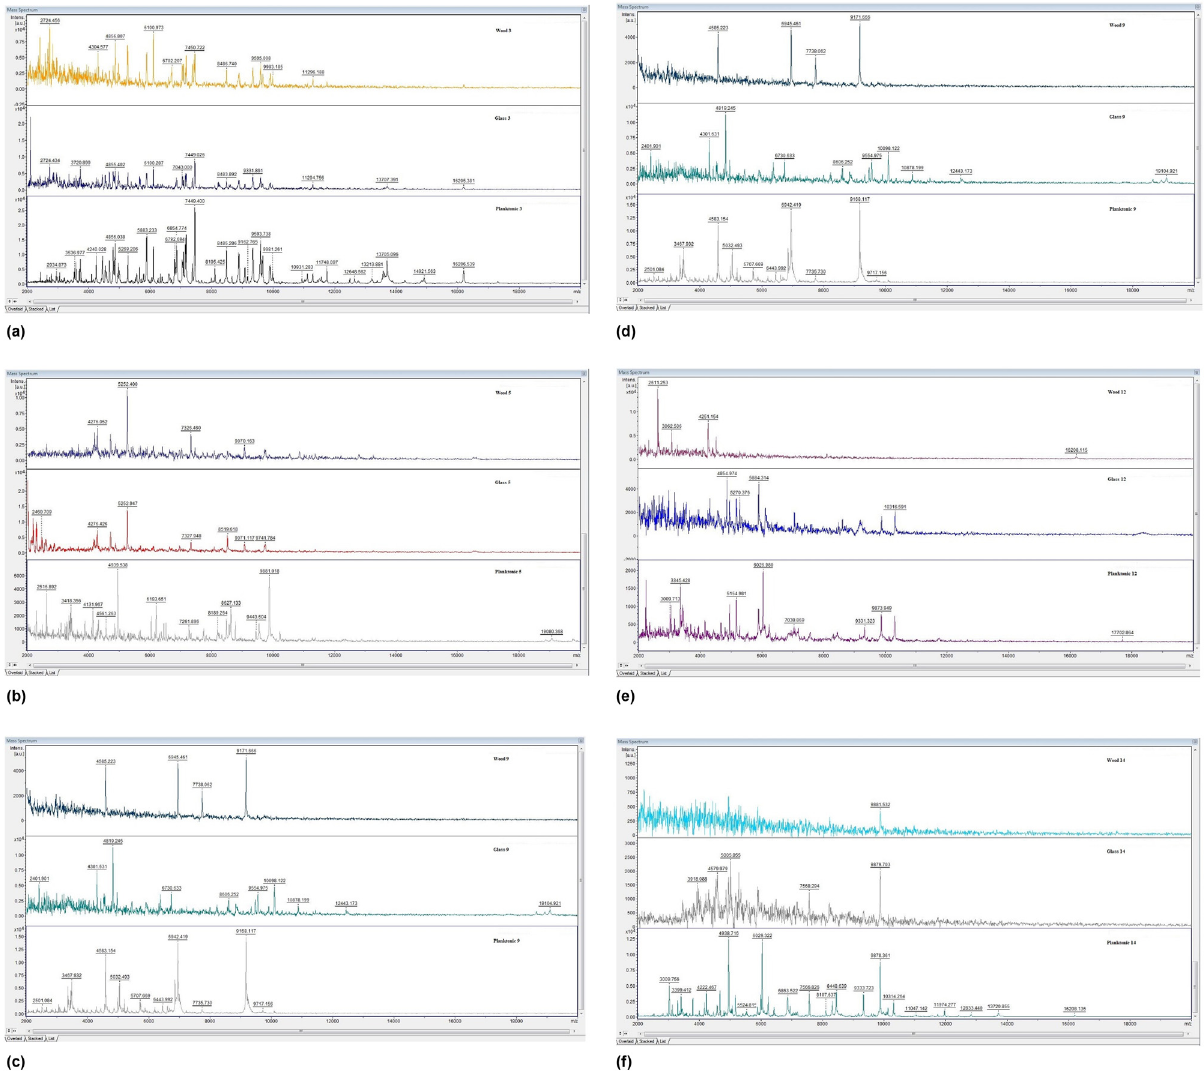
Figure 4: B. subtilis MALDI - TOF mass spectra after CCEO treatment, days of experiment: ( a ) 3th, ( b ) 5th, ( c ) 7th, ( d ) 9th, ( e ) 12th, ( f )